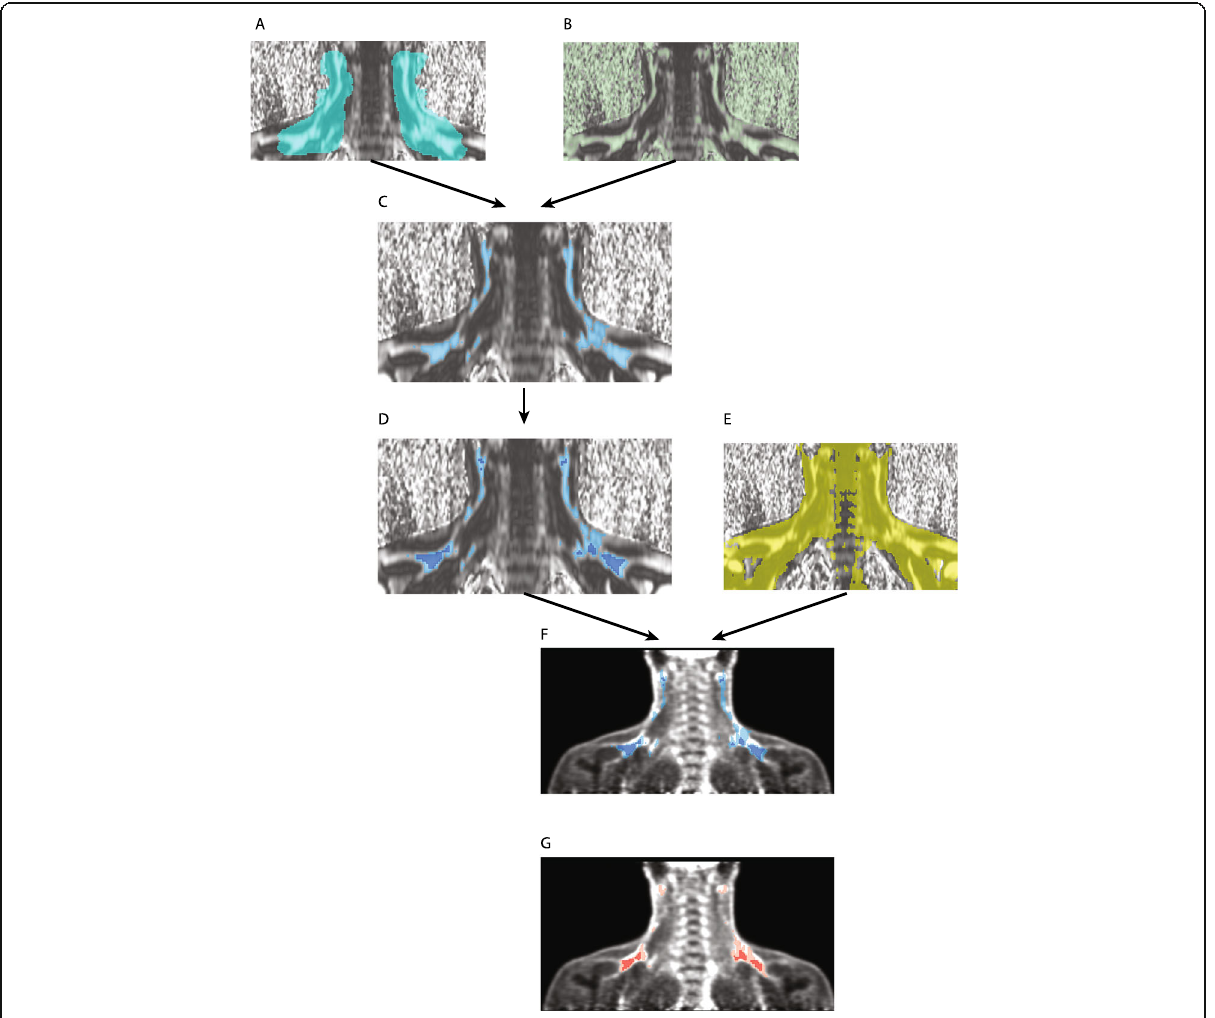
Fig. 2 Image processing workflow. a Segmentation based on a crude manual outline of the adipose tissue in the neck region. b Segmentation based on thresholding of the fat fraction volume selecting all voxels with a fat fraction between 400 and 1000 per mille. c Intersection of segmentations a and b leading to an exact representation of the adipose tissue in the neck region. d This segmentation was shrunk by one voxel in each dimension in order to reduce partial volume effects. e To reduce background noise the in-phase volume was thresholded in order to select the contours of the body and intersected with segmentation d resulting in a final segmentation f (overlay with PET data). This segmentation was again intersected with areas within the PET data volume exhibiting SUV values above 1.5 g/ml yielding a representation of